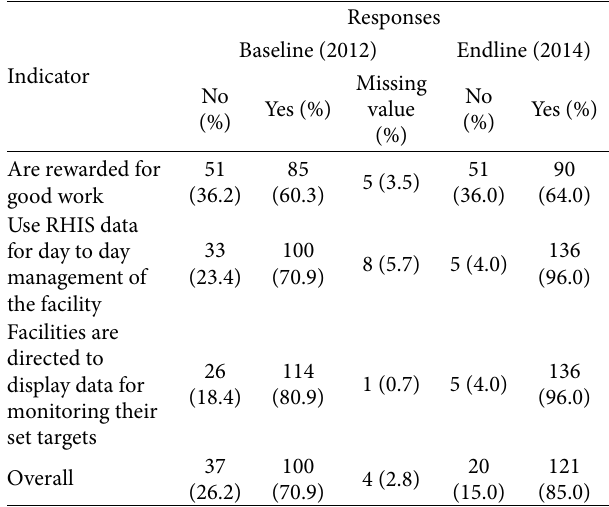
Source: 2012 and 2014 survey.